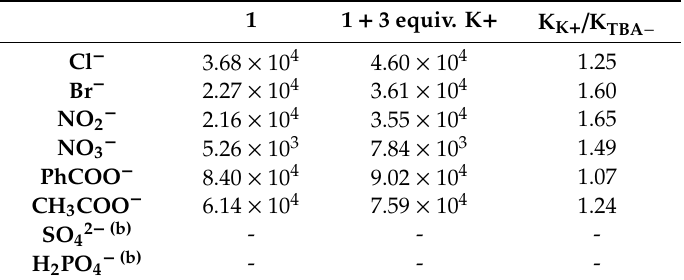
Table 2. Association constants (Ka) for interactions between receptor 1 and selected anions in the absence or presence of 3 equivalent of KPF 6 (a) . 1 1 + 3 equiv. K + K K + / K TBA − Cl − 3.68 × 10 4